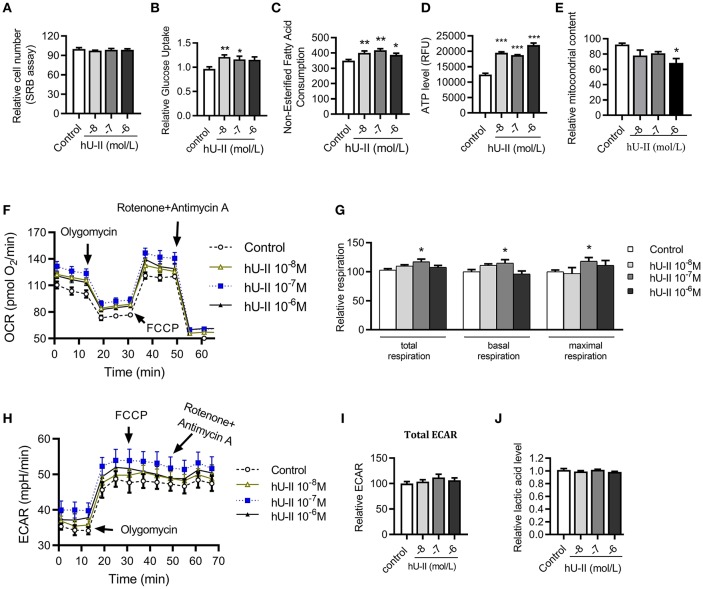
Urotensin-II increased glucose and FFA consumption and increased aerobic respiration in vitro. C2C12 myoblasts were treated with various concentrations of urotensin-II (10−8-10−6 M) for 24 h. (A) Cell number measured by sulforhodamine B assay. (B) Glucose uptake. (C) Fatty acid consumption. (D) ATP production. (E) Mitochondria copy number measured by MitoTracker probe. (F) Oxygen consumption rate (OCR) curve. (G) Total oxygen consumption rate, basal oxygen respiration rate, and maximal oxygen respiration rate. (H) Extracellular acidification rate (ECAR) curve. (I) Total ECAR. (J) Relative lactic acid levels in the supernatant. The data shown are representative of three experiments. Data are represented as the means ± SEM, n = 6; biological replicates. Statistical analysis tested by one-way ANOVA with Dunnett's multiple comparisons test analysis. *P < 0.05, **P < 0.01, ***P < 0.001 for compared with control.